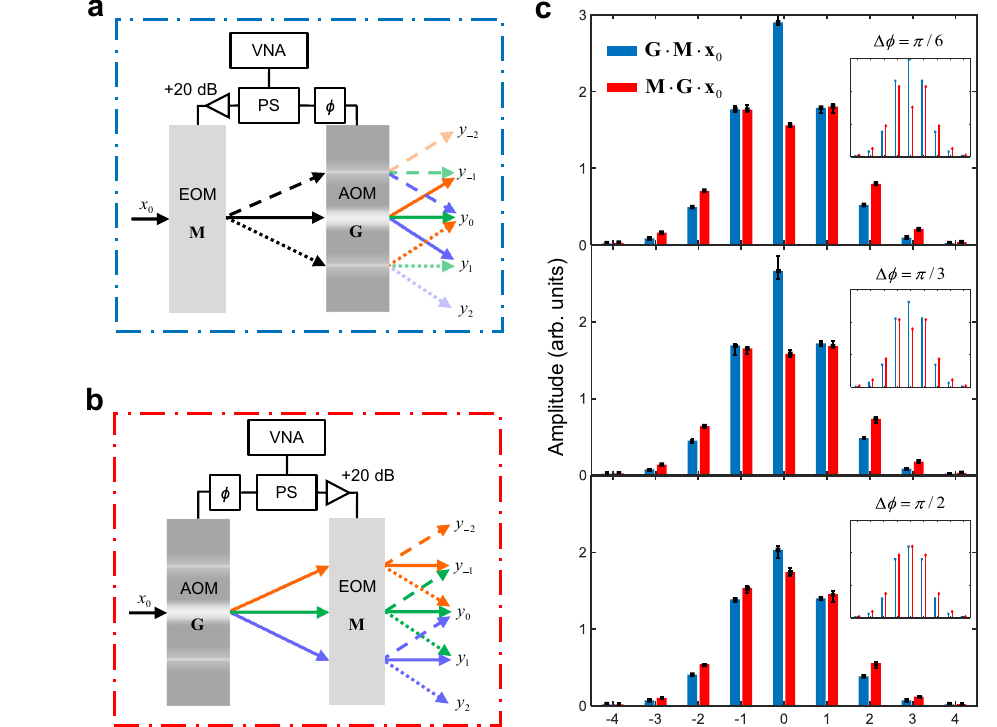
the carrier and ±1st sideband signals by the EOM. y k denotes the output of the k -th syntheticlatticesites.PS:RFpowersplitter;+20dB:RFampli fi erwith20dBgain; ϕ : RF phase shifter. c Contrast of the output between the two concatenation orders G ∙ M ∙ x 0 (blue) and M ∙ G ∙ x 0 (red) with varying phase Δ ϕ at the two modulations. Errorbarsareplottedfrom fi vemeasurements.Insetsarethecorrespondingresults from the theoretical